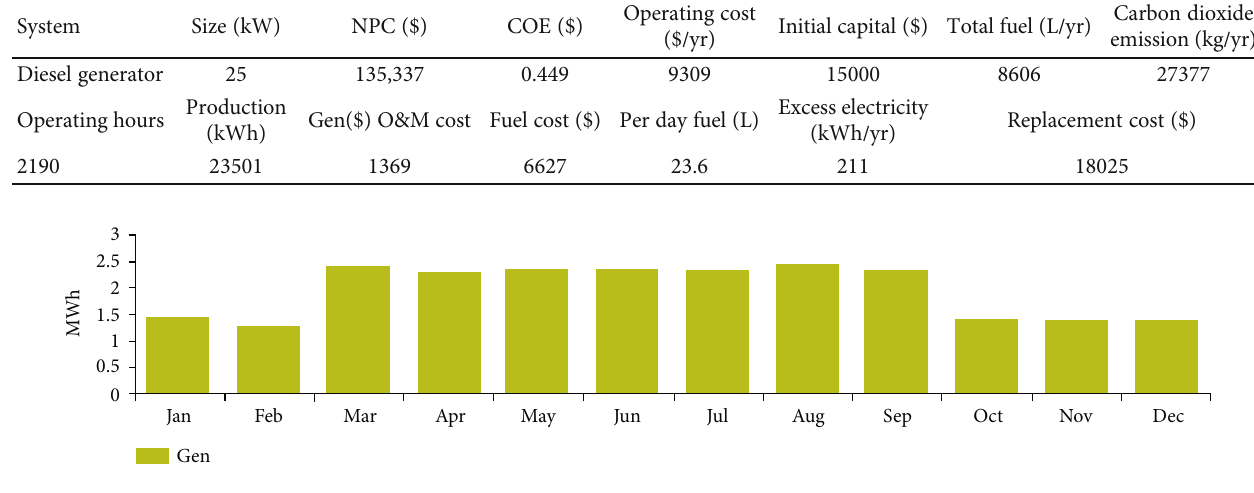
Table 3: Optimized architecture and system cost of primary scenario (net system).